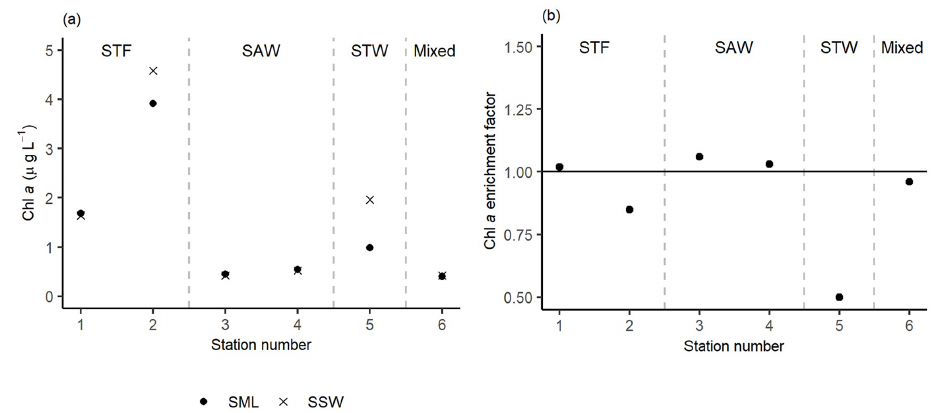
Figure 5. (a) Chl a concentrations in the sea surface microlayer (SML) and subsurface water (SSW), as well as the (b) Chl a enrichment factor. Water mass type is indicated by the label at the top of the figure and separated by the grey vertical dashed lines.